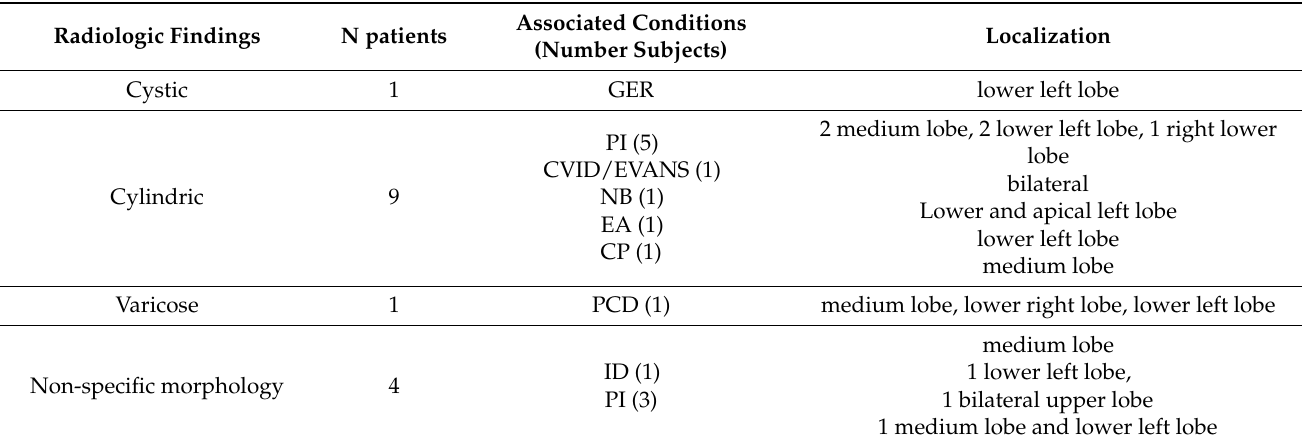
Table 3. Radiologic findings. PI: Post infectious; NB: Neuroblastomas; EA: Esophageal atresia; CP: cardiopathy, ID: